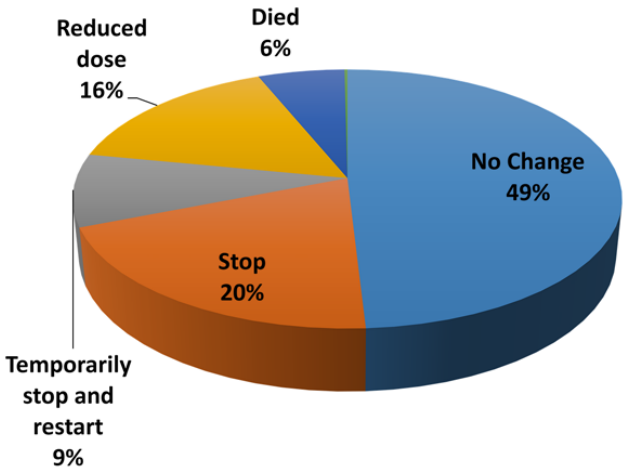
Figure 2. Impact of AE on treatment with Pirfenidone.